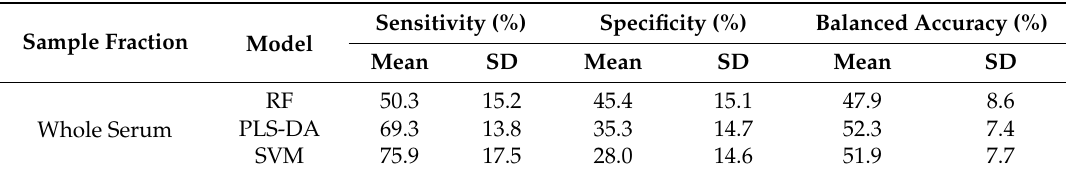
Table 4. Classification results for the IDH1 -mutated versus IDH1 -wildtype whole serum dataset, after 100 resamples. The mean sensitivity, specificity and balanced accuracy are reported with their corresponding standard deviations